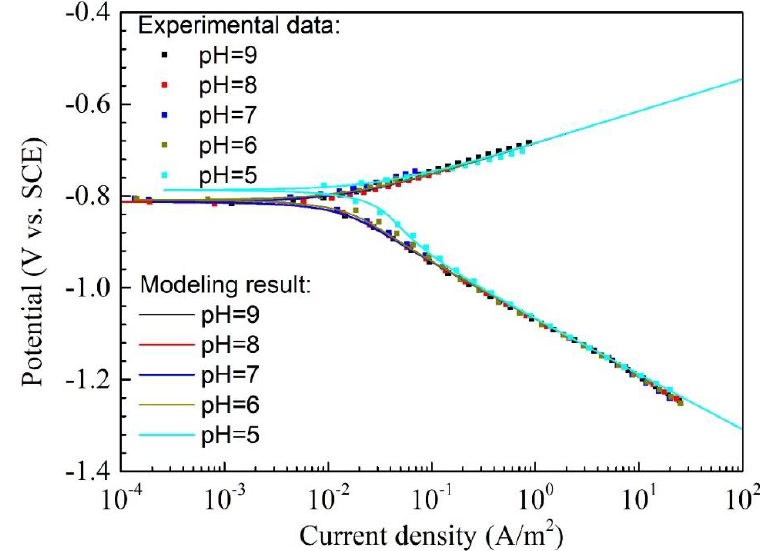
Figure 6. The polarization curves and modeling results of Q345R steel in 1 wt.% NaCl solution with 0.08 mg/L oxygen at different pH under 30 ◦ C. Square: experimental data. Solid line: modeling